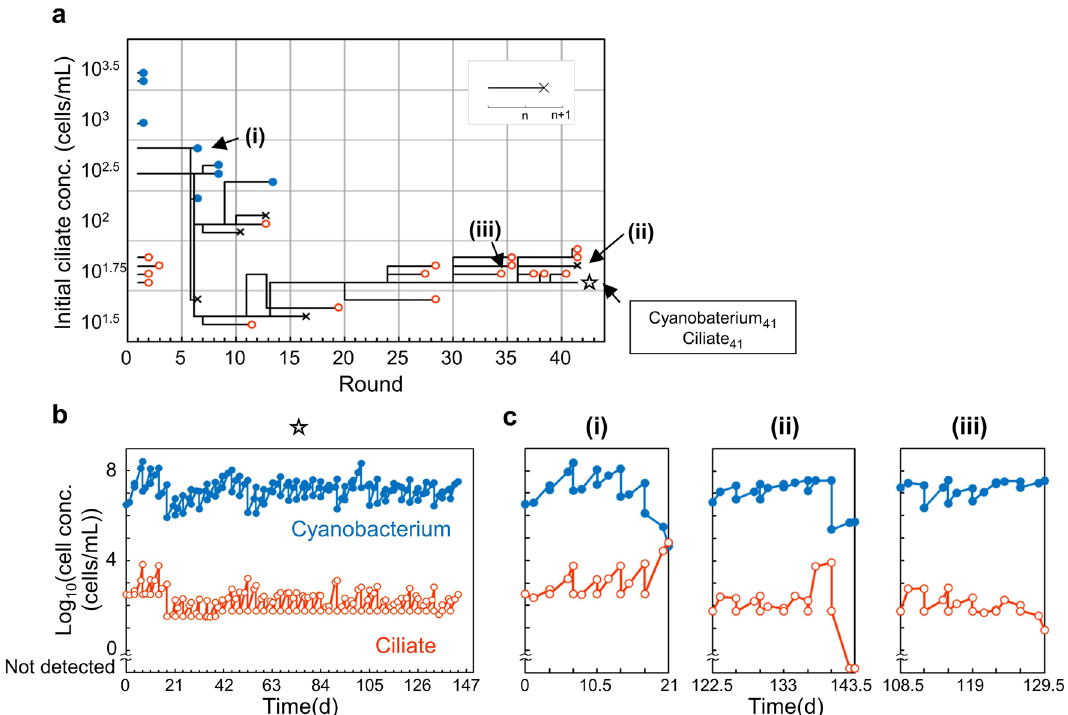
Figure 4. Serially transferred cocultures of the cyanobacterium and ciliate. ( a ) Family trees of the serially transferred cocultures showing the relation between parental cultures and their derivative lineages. Length of the black horizontal lines represents the duration from the start of the lineages to the end. The vertical axis is the initial cell concentration of the ciliate, but the values are not continuous. The initial concentrations within each ticks frame are the same, and the values are depicted (e.g., the initial concentration of the four lineages with red-open circles from round 1 are all 10 1.75 cells/mL). The longest transfer (round 41) was denoted using a star, and the cells obtained from the end of this 41st-round coculture were designated as Cyanobacterium 41 and Ciliate 41 . The causes of the stop of the propagation were distinguished using three symbols, blue-closed circles, black crosses, and red-open circles, corresponding to the three patterns shown in ( c ) (i), (ii), and (iii), respectively, as described in detail in the main text. A symbol at round n indicates that its lineage experienced round n and stopped before round n + 1. ( b ) Growth curves of the longest lineages. ( c ) Growth curves of representative lineages whose propagation had been stopped by different causes. The end-points of each growth curve are indicated using arrows in ( a ). Blue-closed and red-open circles correspond to the growth curves for the cyanobacterium and ciliate, respectively. (i) Cyanobacterial concentration decreased due to the ciliate overgrowth. (ii) Initial cyanobacterial concentration became too low due to high-magnification dilution. (iii) The ciliate population did not